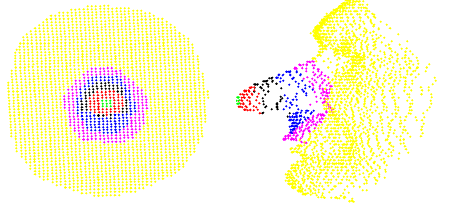
Fig. 2. The 3D surface is separated by several shells around a